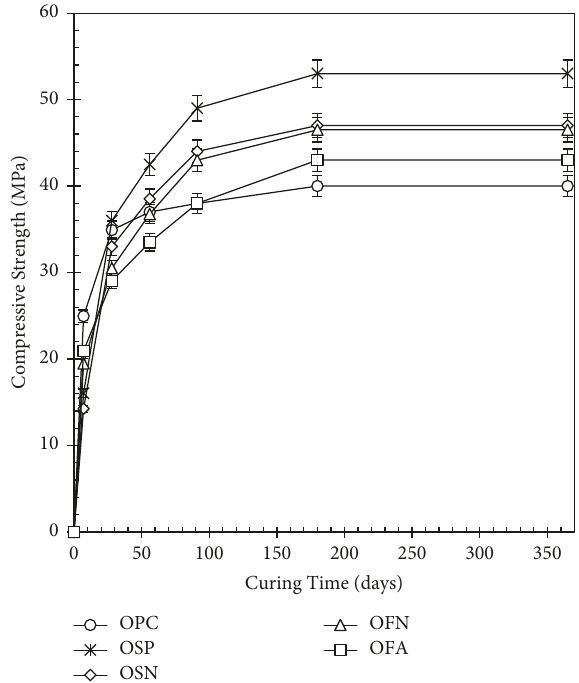
Figure 4: Development of compressive strength of concrete.